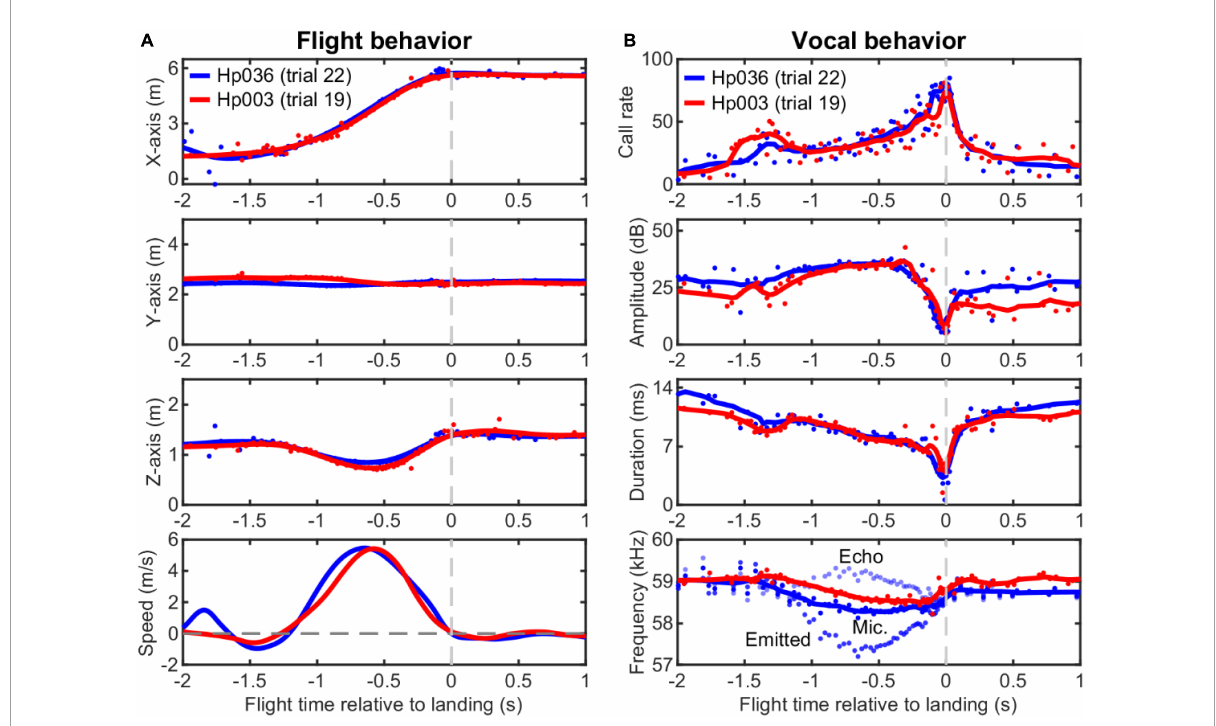
FIGURE2 Example flight and echolocation behavior of two individuals of Hipposideros pratti trained to approach and land on a platform in a flight room. (A) Reconstructed three-dimensional (3D) spatial position and the estimated flight speed of the bats using a nine-microphone array mounted on the wall. (B) Dynamic adjustments of call parameters of the bats during the approaching flight. Note the highly consistent vocal pattern of the bats for the adjustments of call rate, call amplitude, and call duration that can signify the time of landing events. The call amplitude was measured directly from the central microphone of the array without extra compensation. Based on flight speed (relative to the microphone wall) and call frequency recorded by the static (ground) microphones, the emitted call frequency, and the received echo frequency can be estimated. Thus, we assumed that here that the bat performed DSC using echoes from the microphone wall to its front. For clarity, here we only plotted the emitted call frequency and echo frequency for Hp036. For all panels, original data points are shown as circles and the smoothed traces (nine-point moving average) are shown as solid